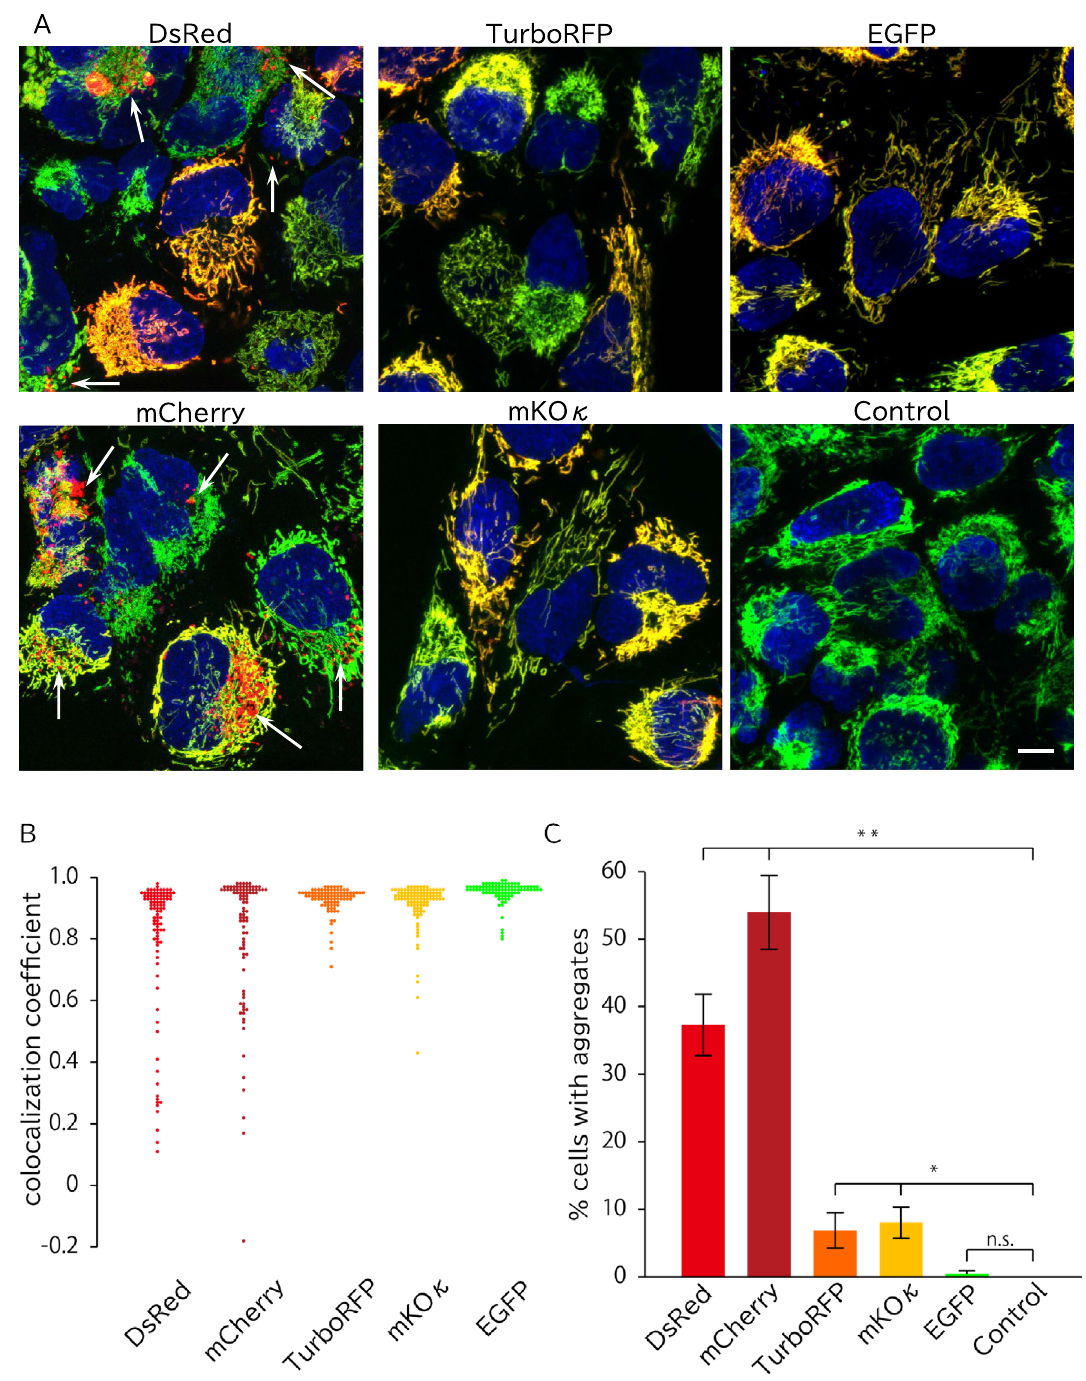
Figure 2. Aggregate formation of mitochondria targeted mCherry and DsRed proteins. ( A ) Representative images of iAECs transduced with each mitochondria-targeted protein or uninfected control stained with MitoTracker and Hoechst. Merged images of each color are shown. Blue: Hoechst 33342. For DsRed, mCherry, TurboRFP mKOκ and uninfected control, green: MitoTracker Green, red: each fluorescent protein. For EGFP, green: EGFP, red: MitoTracker Orange. Scale bar = 10 µm. ( B ) Distribution of the colocalization coefficients of fluorescent proteins and MitoTracker of the cells. Each group included at least 80 cells from 7 optical fields. ( C ) Proportion of cells with aggregates in the mitochondria-targeted fluorescent protein-transduced cell population. Data are shown as the mean ± SD, n = 3 biological replicates. Each replicate included at least 80 cells from 7 optical fields. **p < 0.01, *p < 0.05 n.s.: not significant (p > 0.05); Tukey’s HSD test. All cells were infected with lentivirus at an MOI of